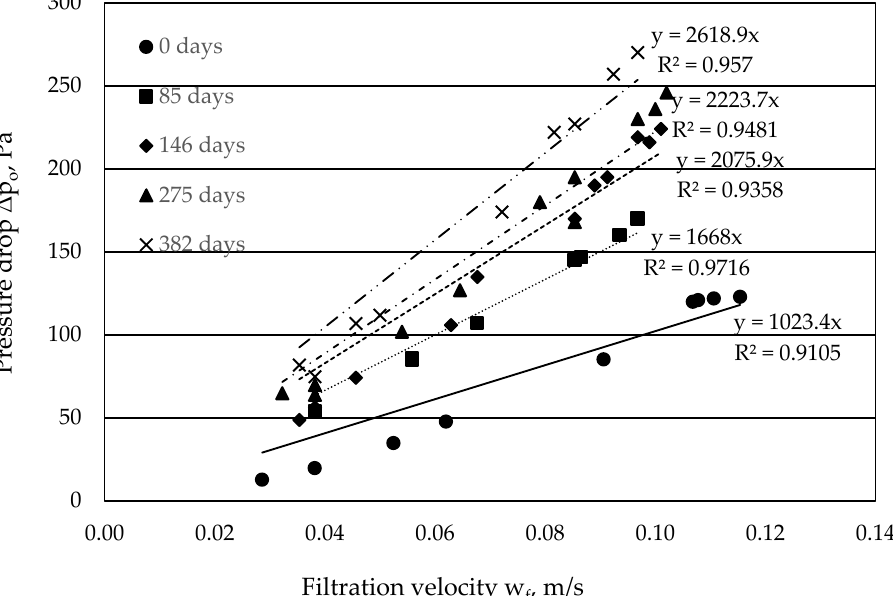
Figure 3. Pressure drop across clean filter media from narrow-surface treatment line—service life of the bags: 0, 85, 146, 275, and 382 days.